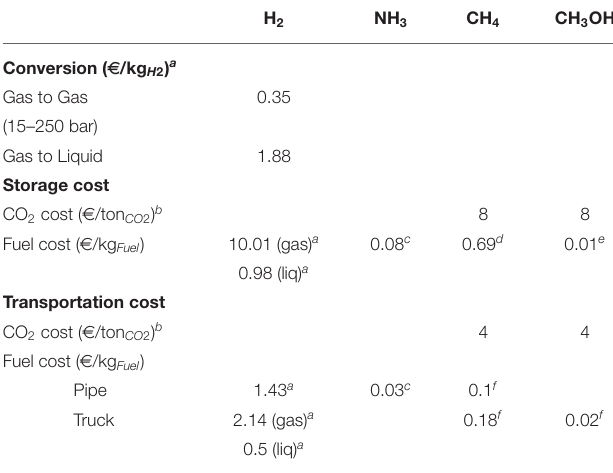
TABLE 5 | Hypotheses for the production costs—based on Tremel et al. (2015), Atsonios et al. (2016), and Brynolf et al. (2018). Hypotheses